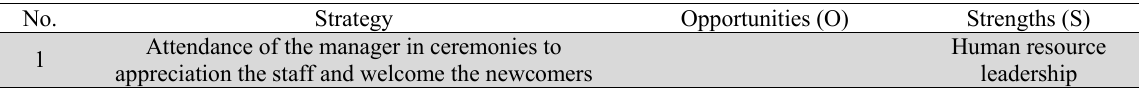
Human resource leadership